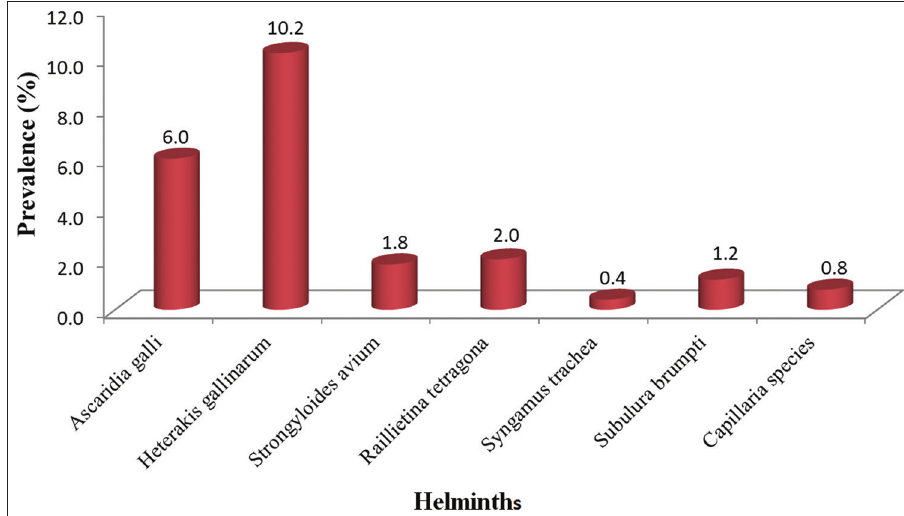
Figure-2: Prevalence (%) of gastrointestinal helminths of intensively managed poultry in Kwara Central, Kwara